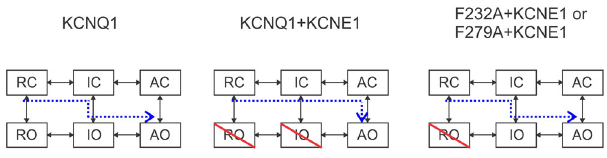
Fig. 9 Gating model for KCNQ1, KCNQ1/KCNE1, KCNQ1-F232A/KNCE1, and KCNQ1-F279A/KNCE1 channels. A simpli fi ed six-state model with three closed states and three open states. Horizontal transitions are two- step S4 activation while vertical transition is the channel opening. Upon activation, S4 moves from the resting state to the intermediate state and then to a fully activated state in both KCNQ1 and KCNQ1/KCNE1 channels. The KCNQ1 channel is suggested to open in both states, whereas the KCNQ1/KCNE1 channel only opens from the AO state. IO state is suppressed in KCNQ1/KCNE1 channels. F232A and F279A change the VSD – PD coupling and allow KCNQ1/KCNE1 channels to open from the IO state. RO state is suppressed in wt and mutant KCNQ1/KCNE1 channels at negative voltages. RC: resting closed; IC: intermediate closed; AC: activated closed; RO: resting-open; IO: intermediate-open; AO: